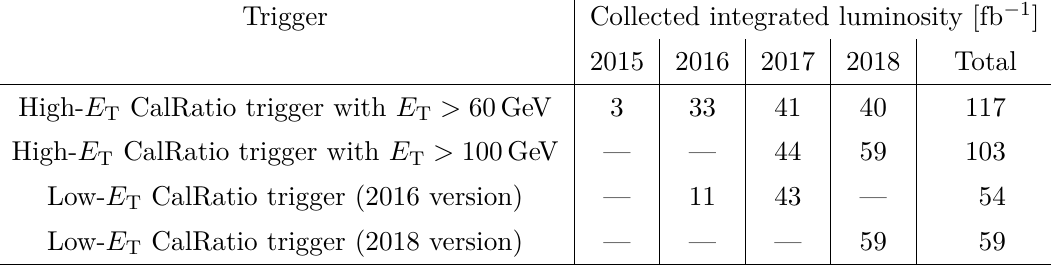
Table 1. CalRatio triggers which were available during the LHC Run 2 data-taking, and corresponding integrated luminosity collected in each period. The high- E T CalRatio trigger with E T > 60 GeV was disabled in 2017 for instantaneous luminosities higher than 1 . 4 × 10 34 cm − 2 s − 1 . Two versions of the low- E T CalRatio trigger were used, with slight differences in their algorithms. The details are reported in section